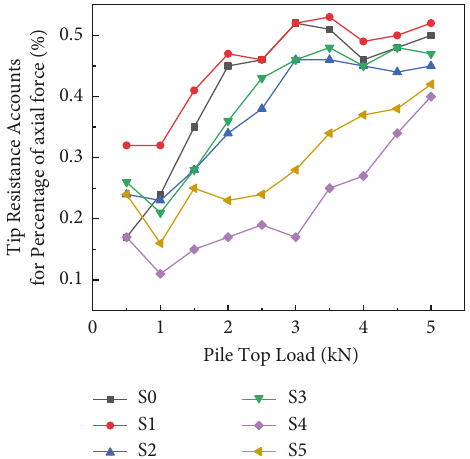
Figure 18: Relation curves between the tip resistance account for the percentage of axial force and pile top